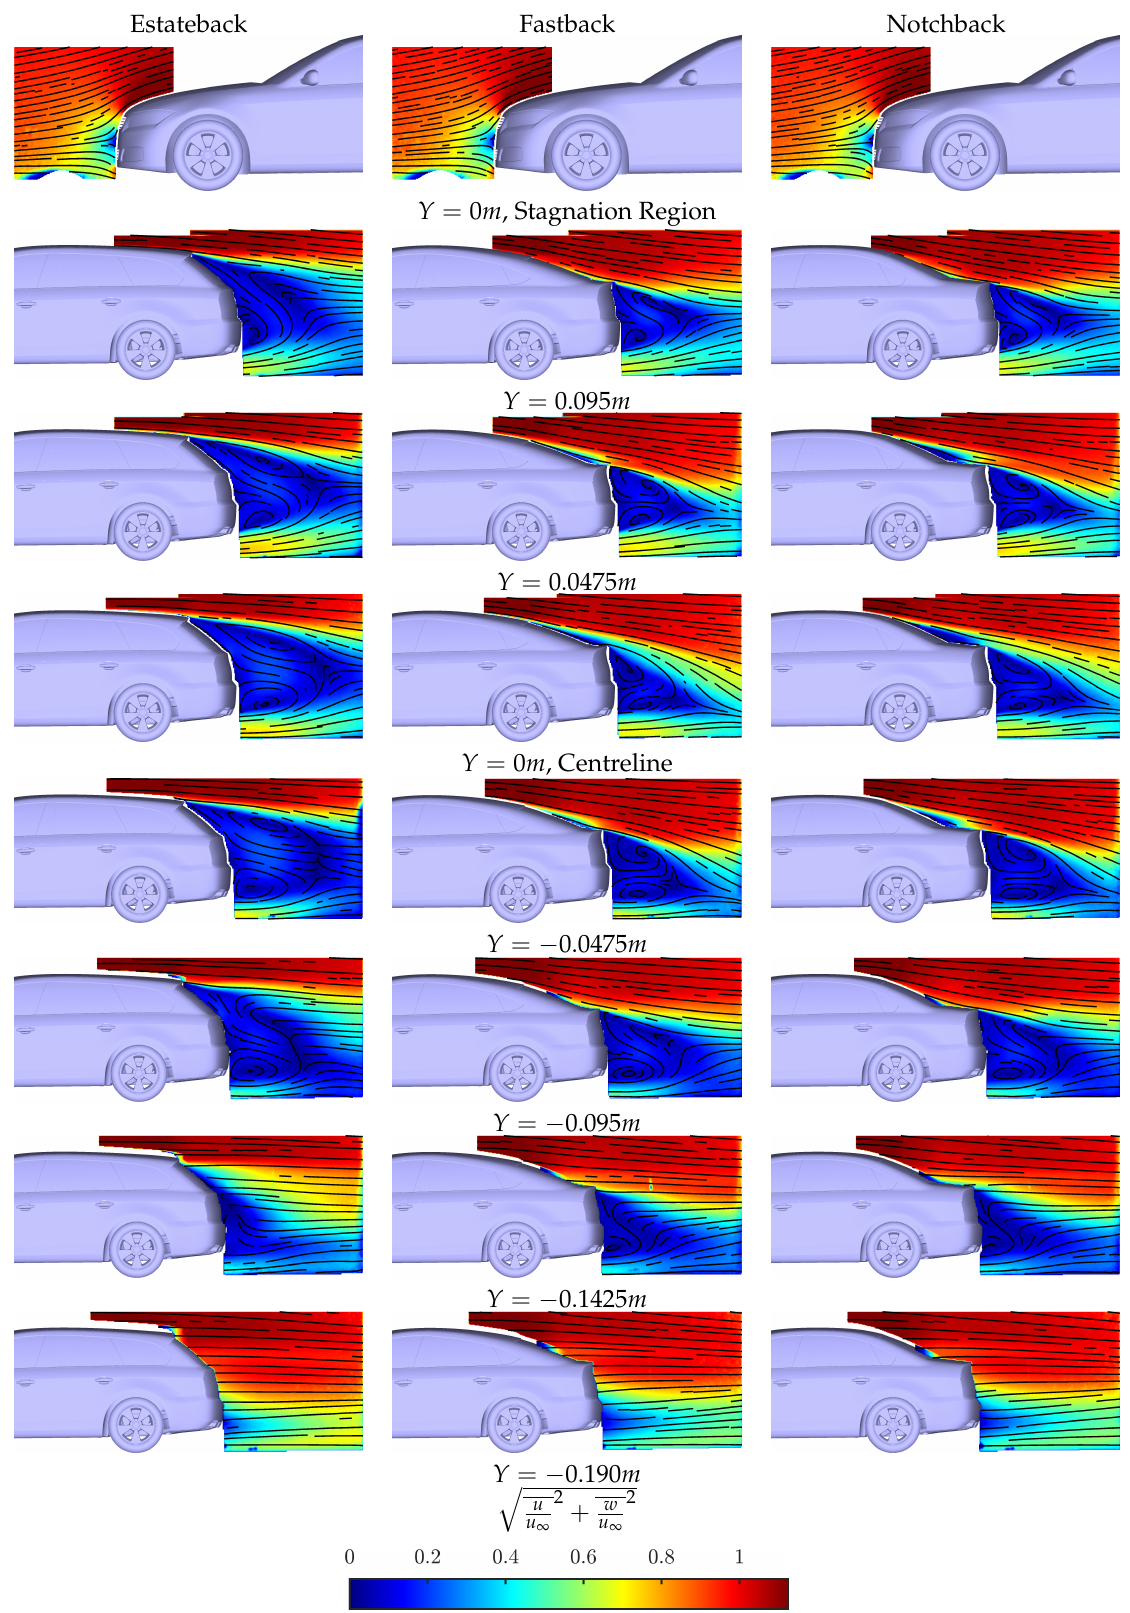
Figure 14. Side profile for all PIV planes of normalised velocity magnitude for all three DrivAer configurations